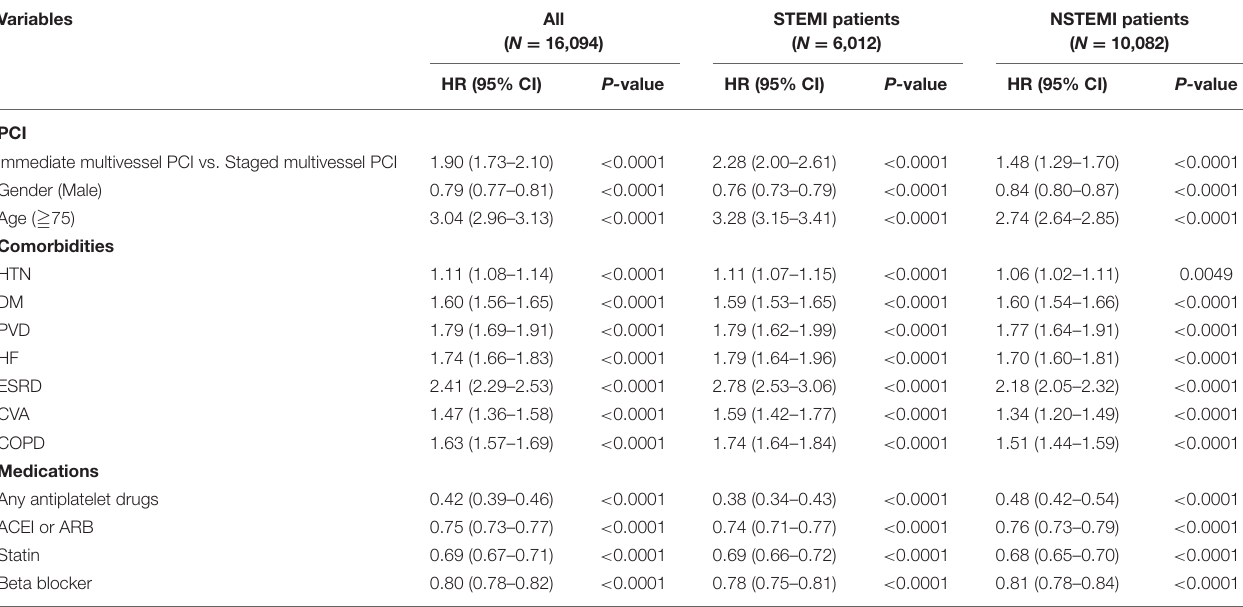
TABLE 4 | Cox proportional hazards regression analysis for AMI patients with multivessel disease and subgroup analysis of different AMI